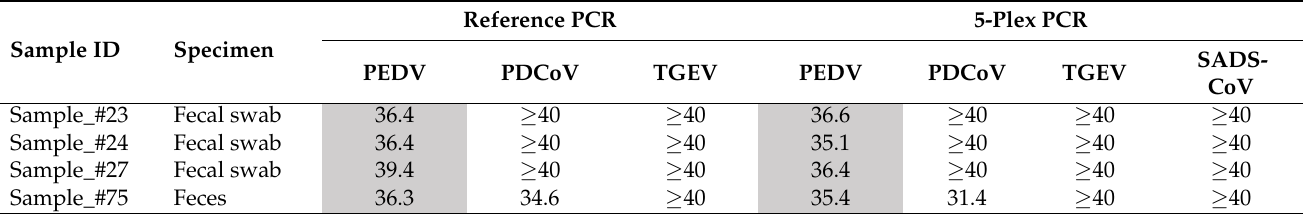
Table 10. Discrepancies on clinical samples between the